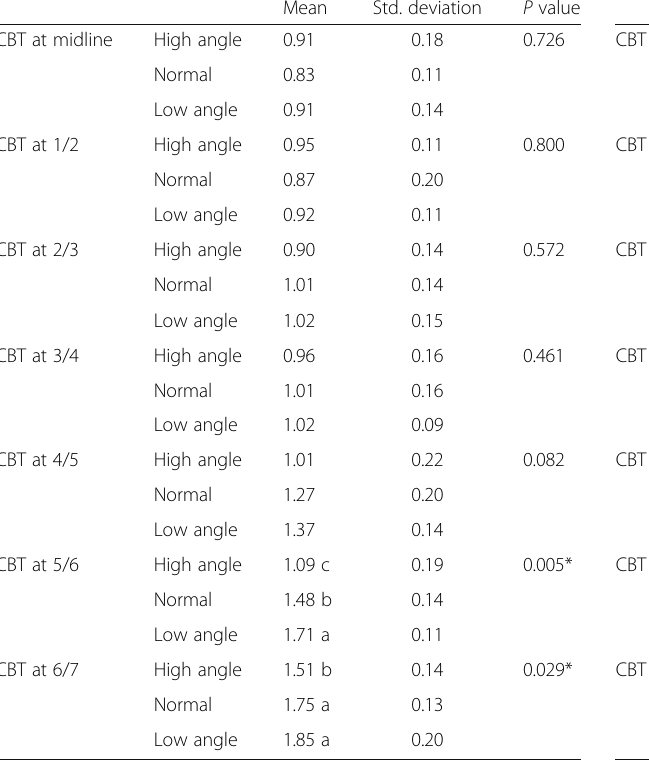
Table 6 Measurements of buccal inter-radicular cortical bone Table 5 Measurements of buccal inter-radicular cortical bone thickness at 7 mm from the alveolar crest in the lower arch thickness at 4 mm from the alveolar crest in the lower arch Mean Std. deviation Mean Std.